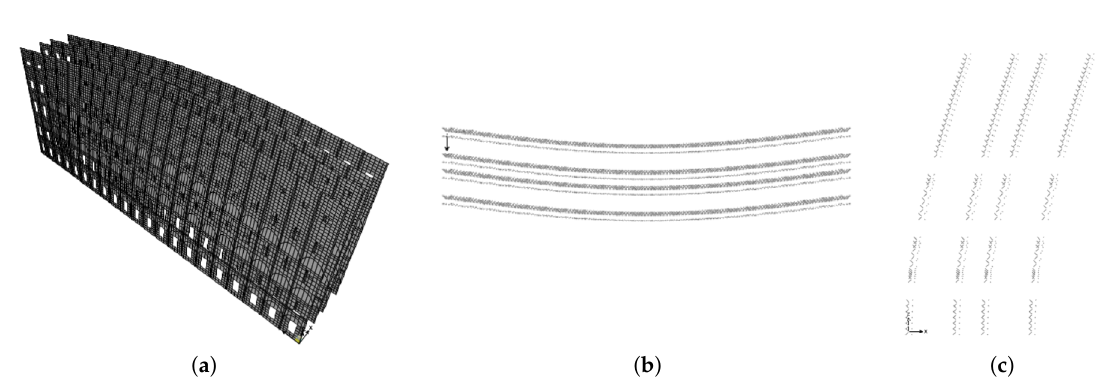
Figure A1. First natural mode of the LW fine model without slabs. Natural frequency f = 0.24 Hz. Modal shape in the: ( a ) 3D space; ( b ) x − z plane; ( c ) y − z